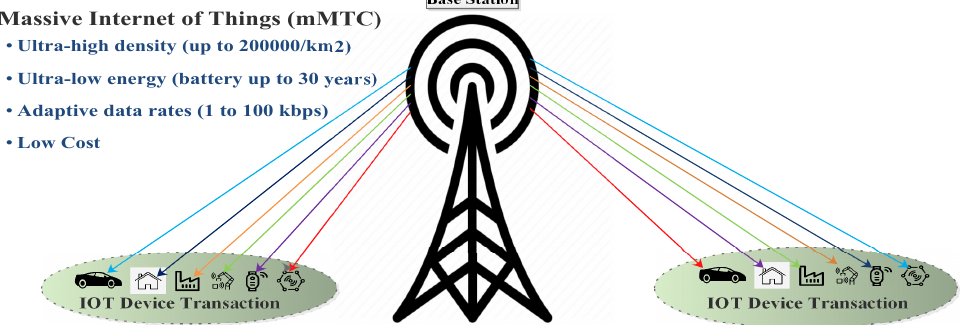
Figure 5. Pictorial representation of IoT with